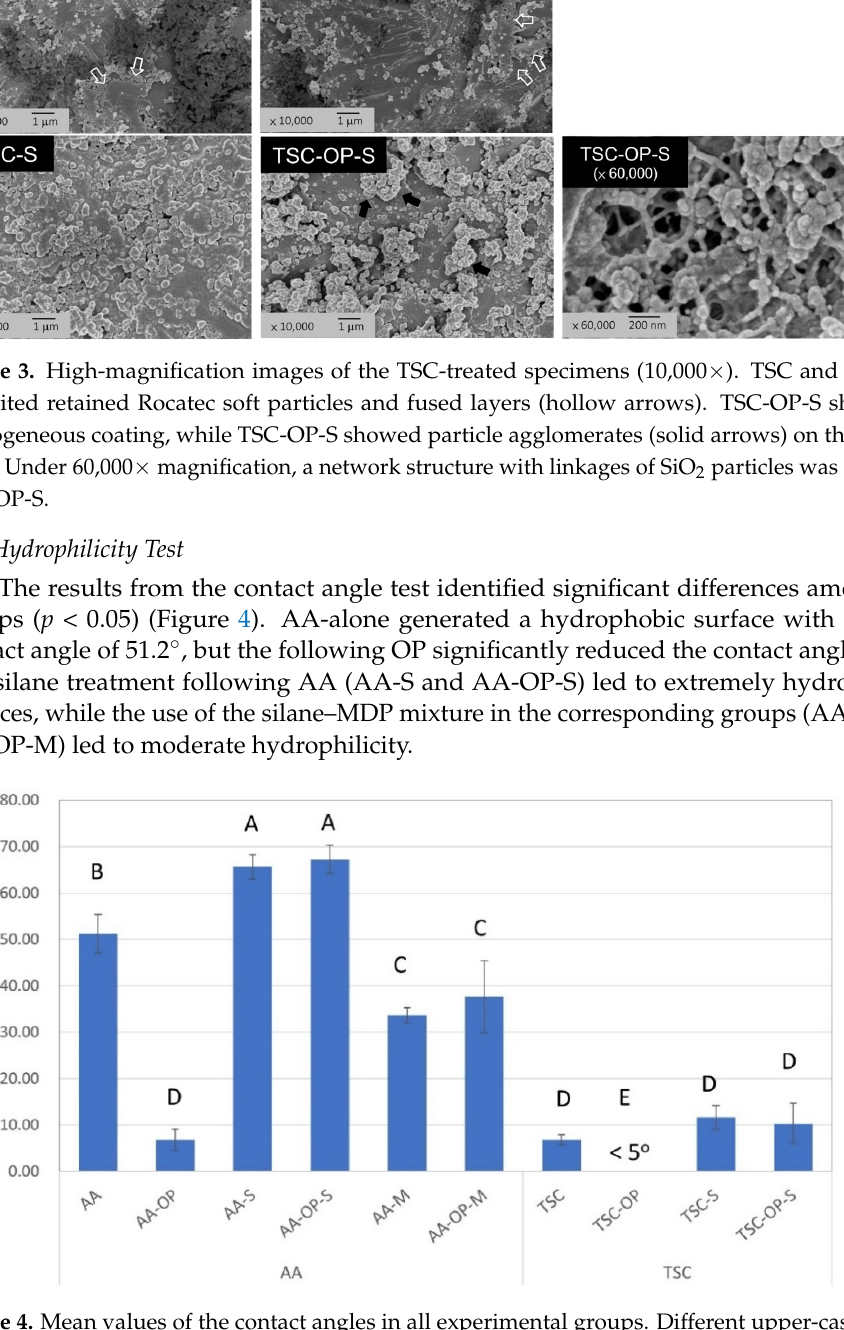
Figure 2. SEM images (1000×) after the surface treatment. Only TSC-OP-S showed an evident homogeneous coating on the grit-blasted surfaces.